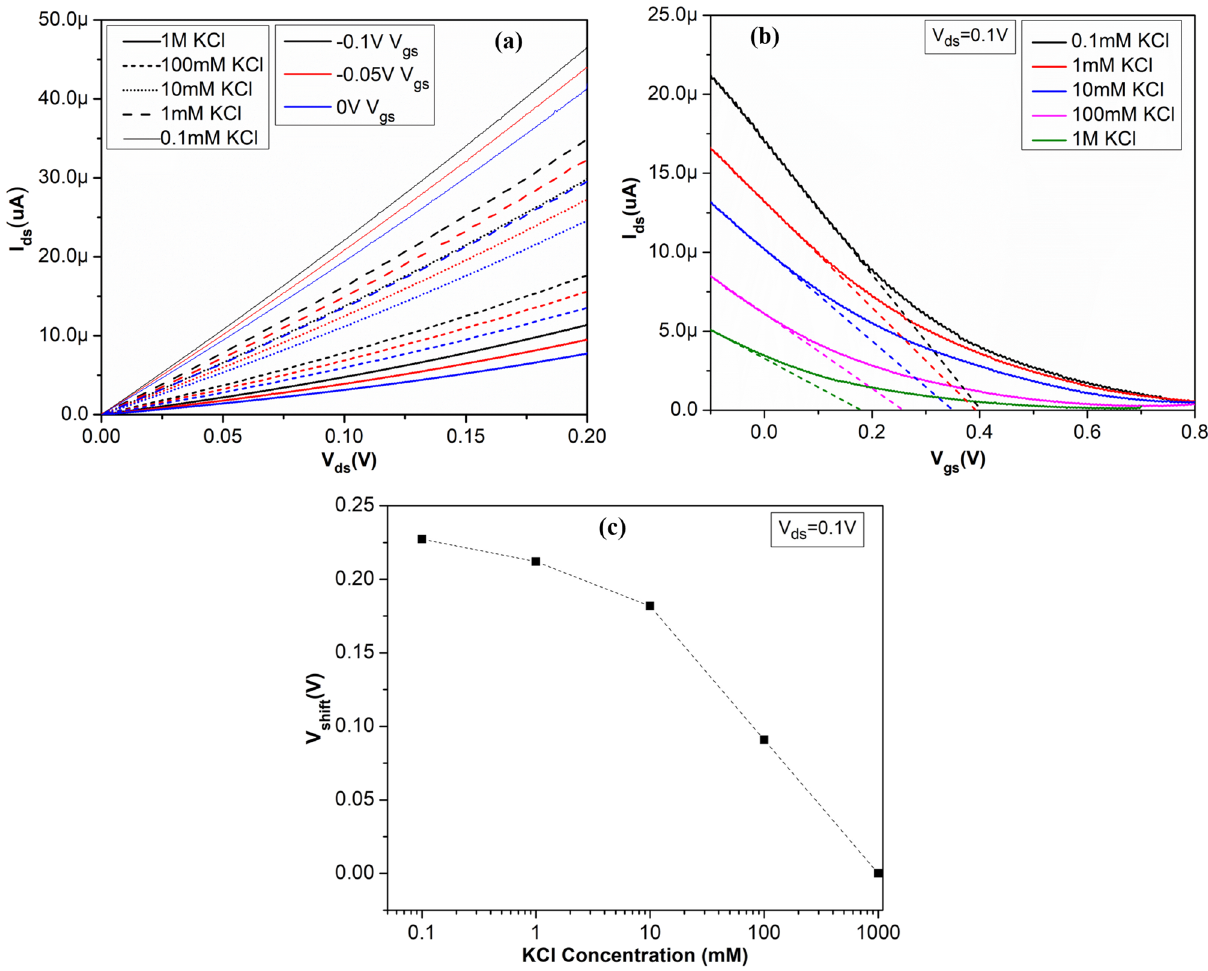
Figure 8. Electrical characteristics of a single device on the chip array (3 × 3) ( a ) Output characteristics for different applied gate voltages for different concentrations of KCl, ( b ) transfer characteristics for different concentrations of KCl at constant voltage V ds ~ 0.1 V, and decrease in V th for the increase in KCl concentrations are shown by fitting (dashed line) the linear region of the corresponding transfer curve for different concentrations and ( c ) V shift for KCl concentrations is plotted while the value for 1 M KCl is taken as voltage is necessary to compensate for this change and the I ds -V gs curve shifts towards more negative gate voltages 41 . The drain current (I ds ) in the linear region is given by the following relation 42